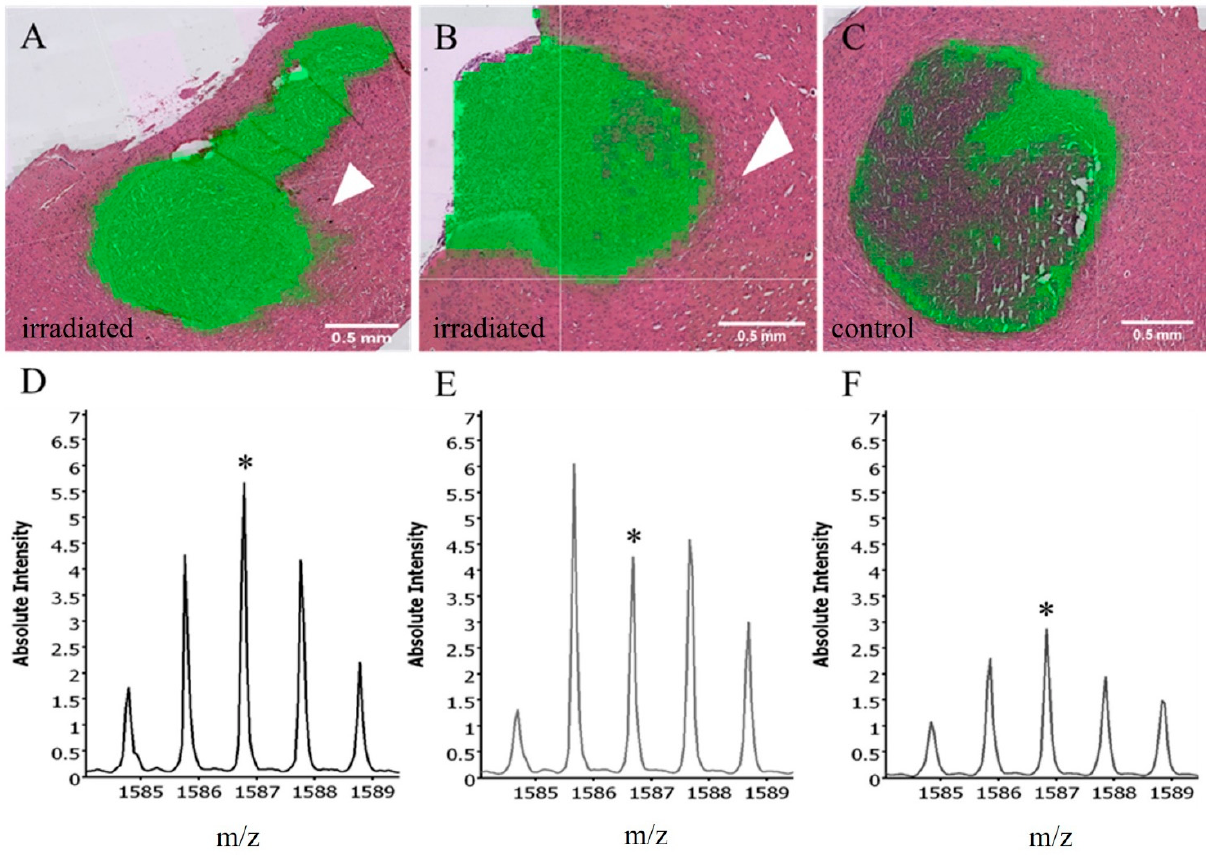
Figure 3. Intensity maps and blots of mass 1586.8 m/z (upper part: green; lower part: marked with *) in three representative U87MG_mCherry tumors indicate an extension and increase of the mass beyond the tumor margins after irradiation with 3 fractions of 3 Gy within the irradiated volume (arrows, ( A / D ) + ( B / E )), in contrast, no expansion can be seen in untreated tumors ( C / F ). Histologically, positivity of Nestin and CD44 was not limited to a small subset